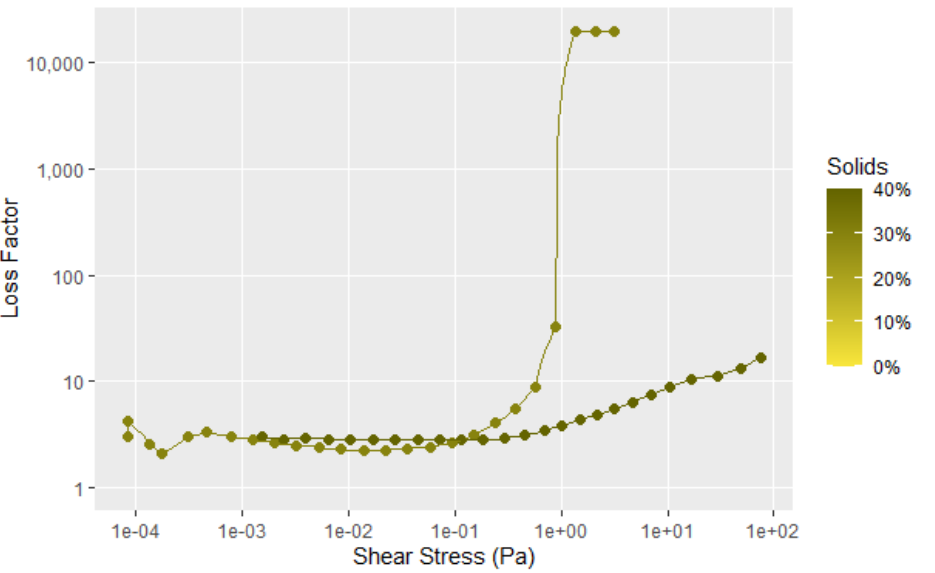
Figure 16. Loss factor for shear stress rheology with increasing amplitude testing of OV with 30% and 40% concentrations.